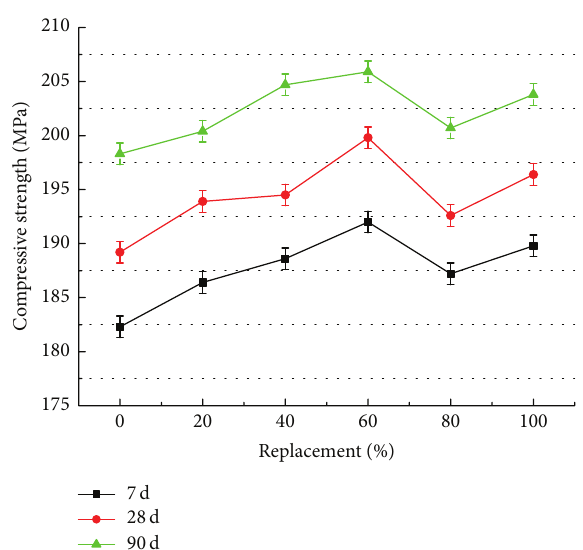
Figure 6: IOT of 0.075 ∼ 1.18 mm instead of silica